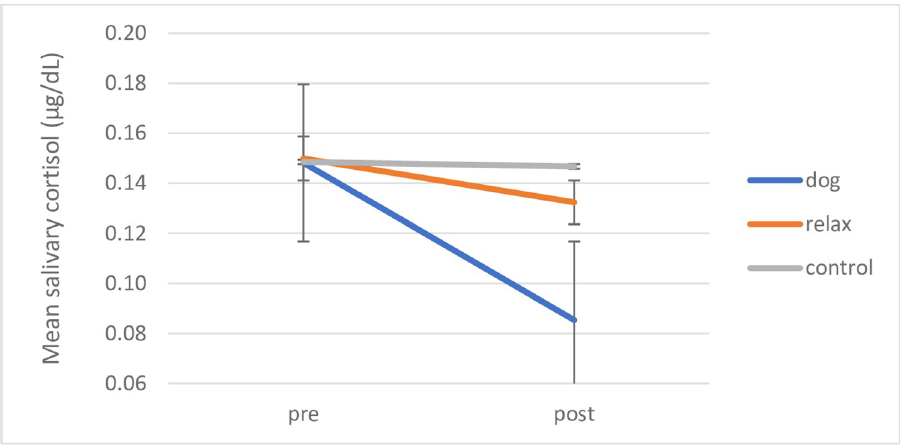
Fig 9. SEN cohort: Group interventions, mean pre-post salivary cortisol by intervention condition. Mean pre-post salivary cortisol levels for children with SEN by intervention condition in group interventions. Error bars indicate standard error of